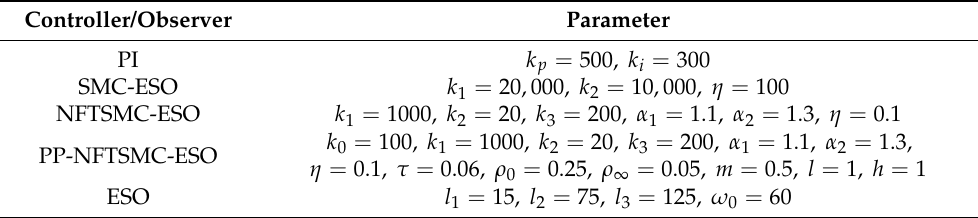
Table 4. The design parameters of the controllers and observers.